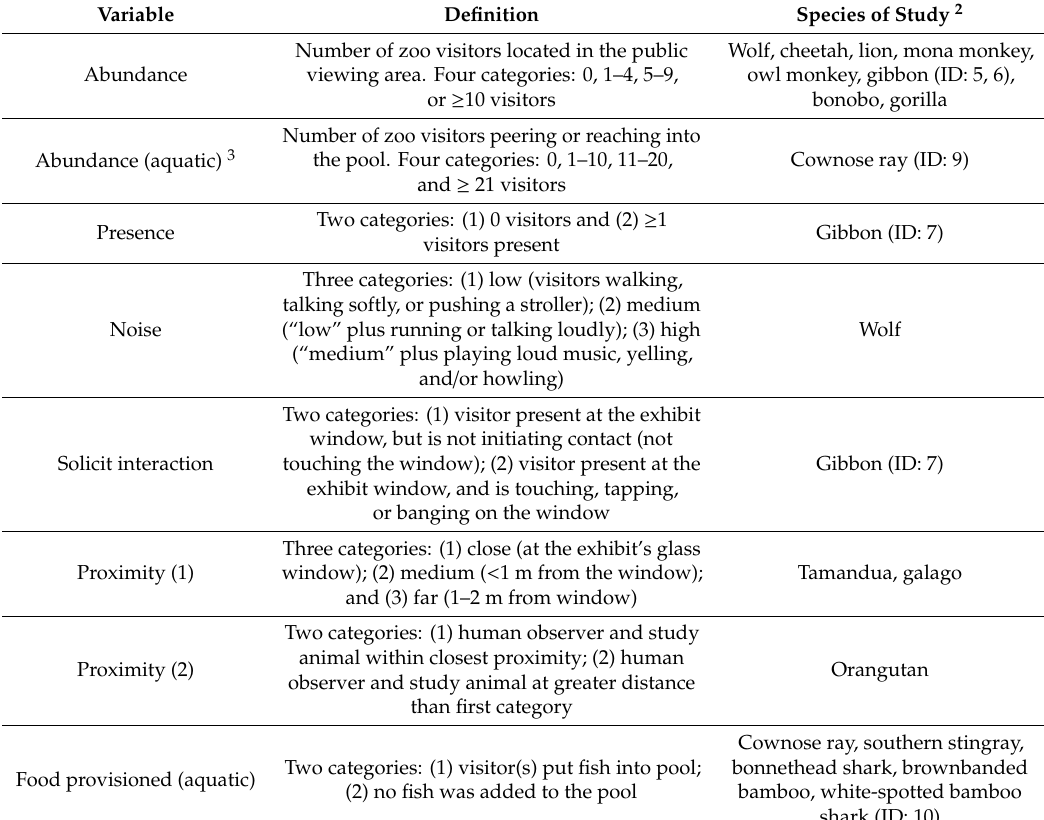
Table 2. Human-focused independent variables addressed in 16 species across 10 studies 1